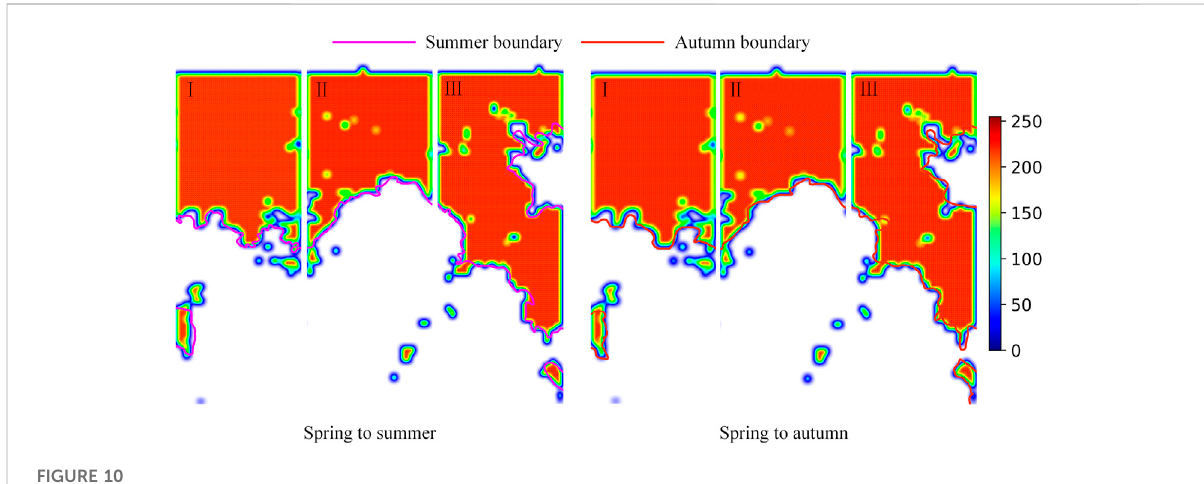
FIGURE 10 Early warning